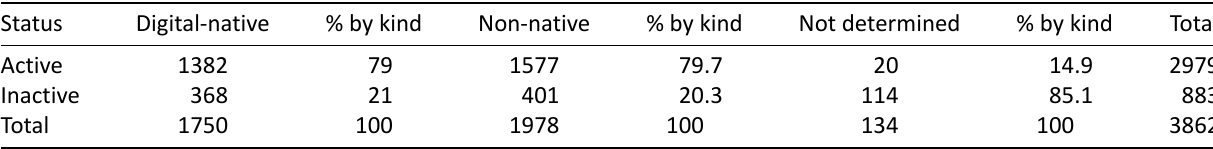
Table 2. Count of active and inactive, digital-native and non-native online media in Spain (N = 3,862, November 2019).